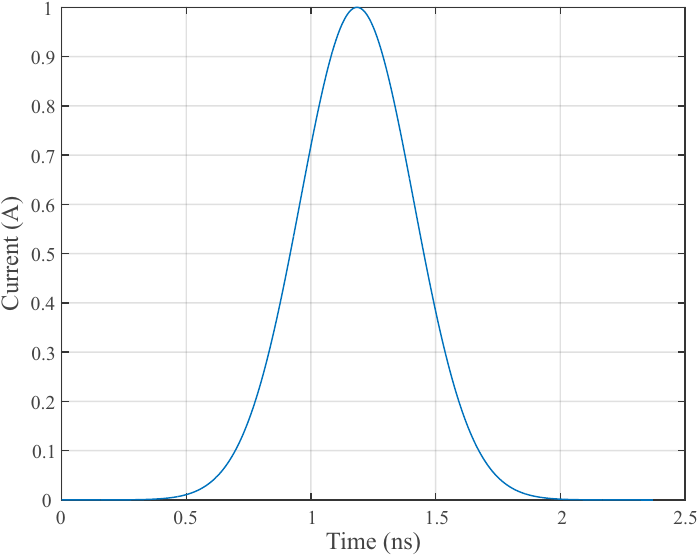
Figure 4. The Gaussian PD current